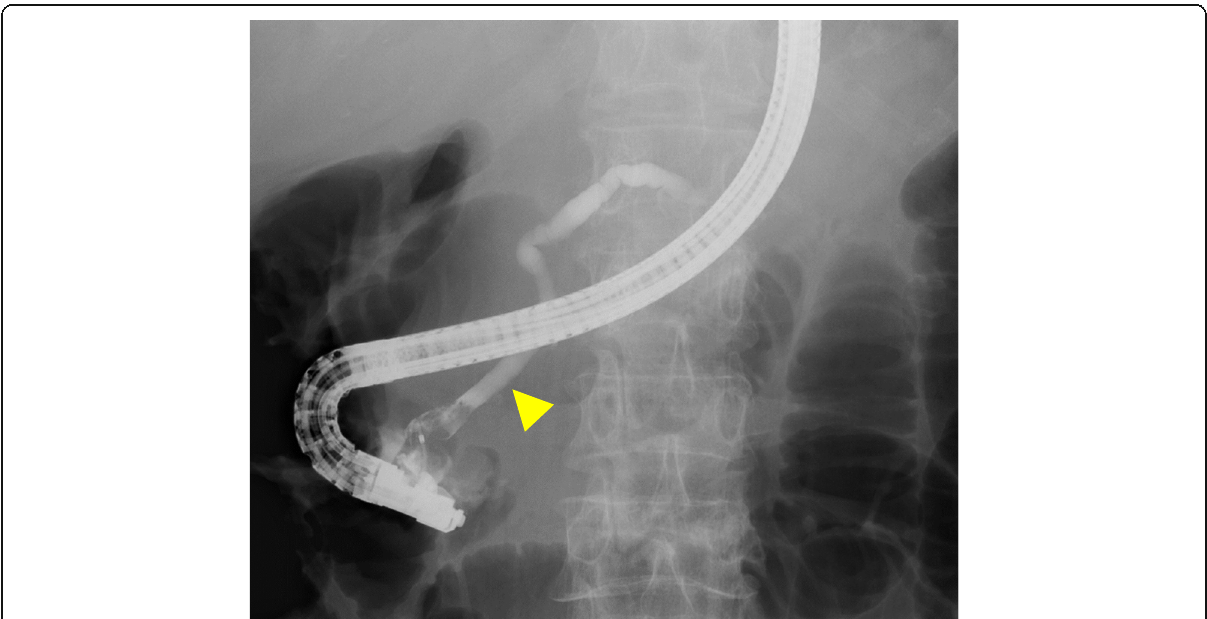
Fig. 2 ERCP revealing a dialated main pancreatic duct (arrow